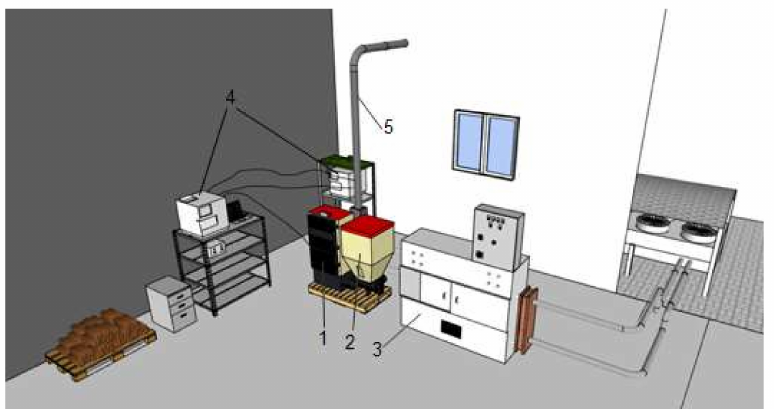
Figure 4. Experimental setup: 1—pellet boiler, 2—fuel tank, 3—heat exchanger station, 4—flue gas analyzers and data logger,